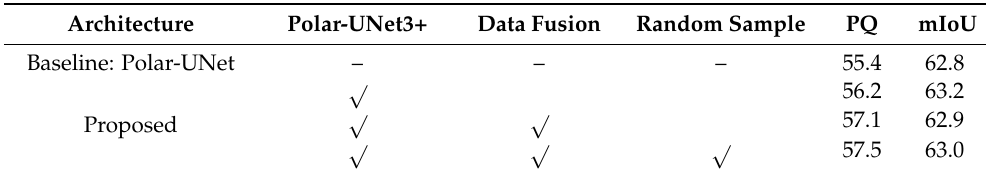
Table 4. Ablation study of the proposed approach with key components (using component) on the validation split of SemanticKITTI. Metrics are provided in [%].